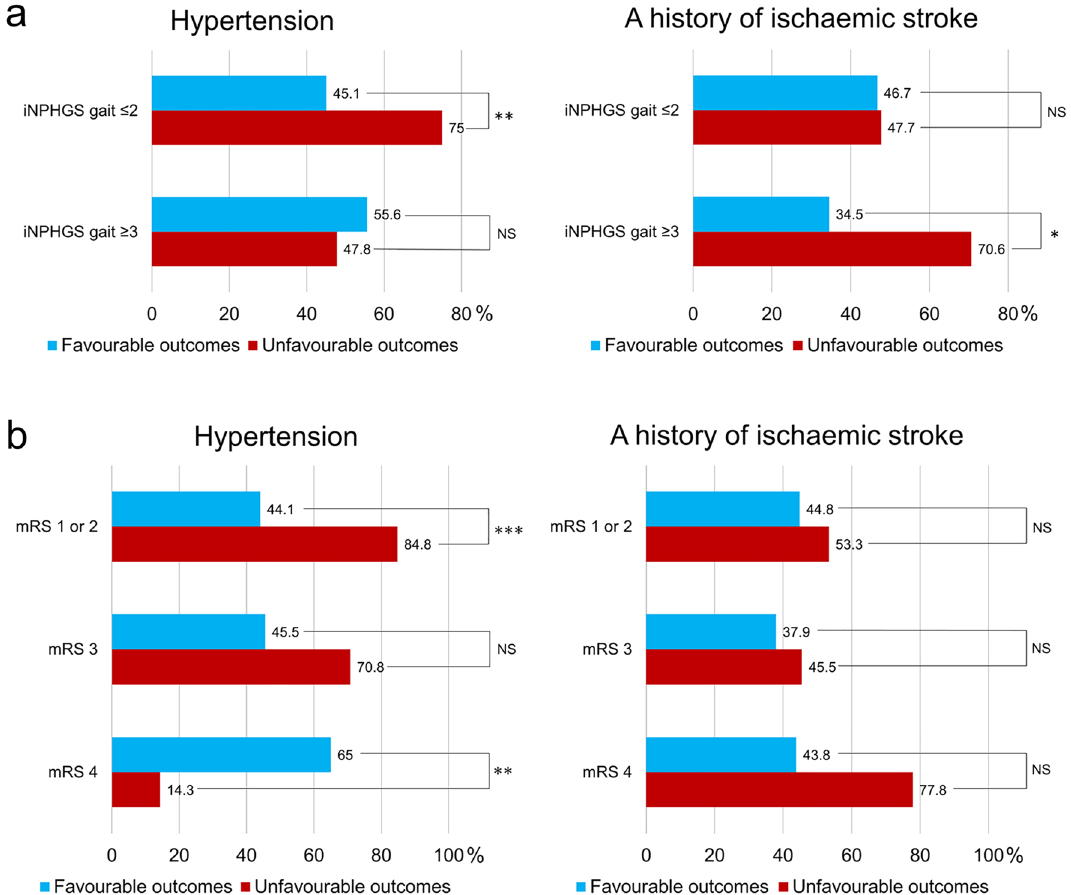
Figure 2. The prevalence of hypertension and ischaemic stroke history. ( a ) Patients with iNPHGS gait subscores of 2 or below and with iNPHGS gait subscores of 3 or above. ( b ) Patients with an mRS grade 1 or 2, grade 3, and grade 4. iNPHGS idiopathic normal-pressure hydrocephalus grading scale, mRS modified Rankin Scale. *p < 0.05, **p < 0.005, ***p <